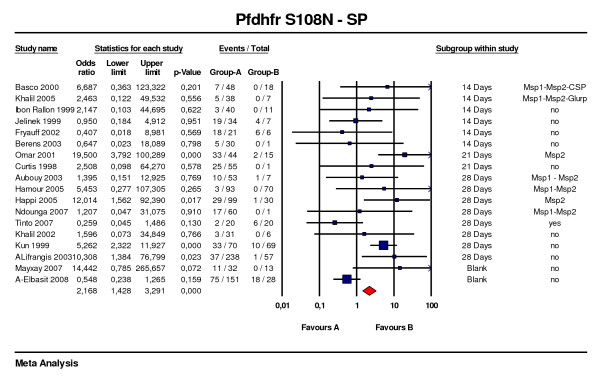
Pfdhfr S108N predictive value of therapeutic failure with Sulfadoxine-pyrimethamine. Studies with different follow-up were included. S108N point mutation was considered irrespective of the presence of other mutations at different Pfdhfr codons. Studies were stratified according first to the duration of the follow-up, second to the use of genotyping for recrudescence, third to the date of publication.